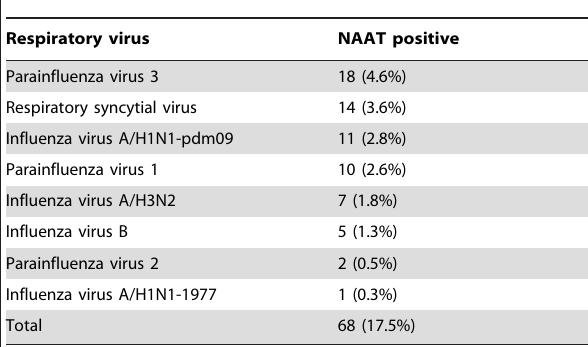
Table 8. Positive results by NAAT for respiratory viruses in children presenting with sore throat or cough and increased respiratory rate or effort ( n